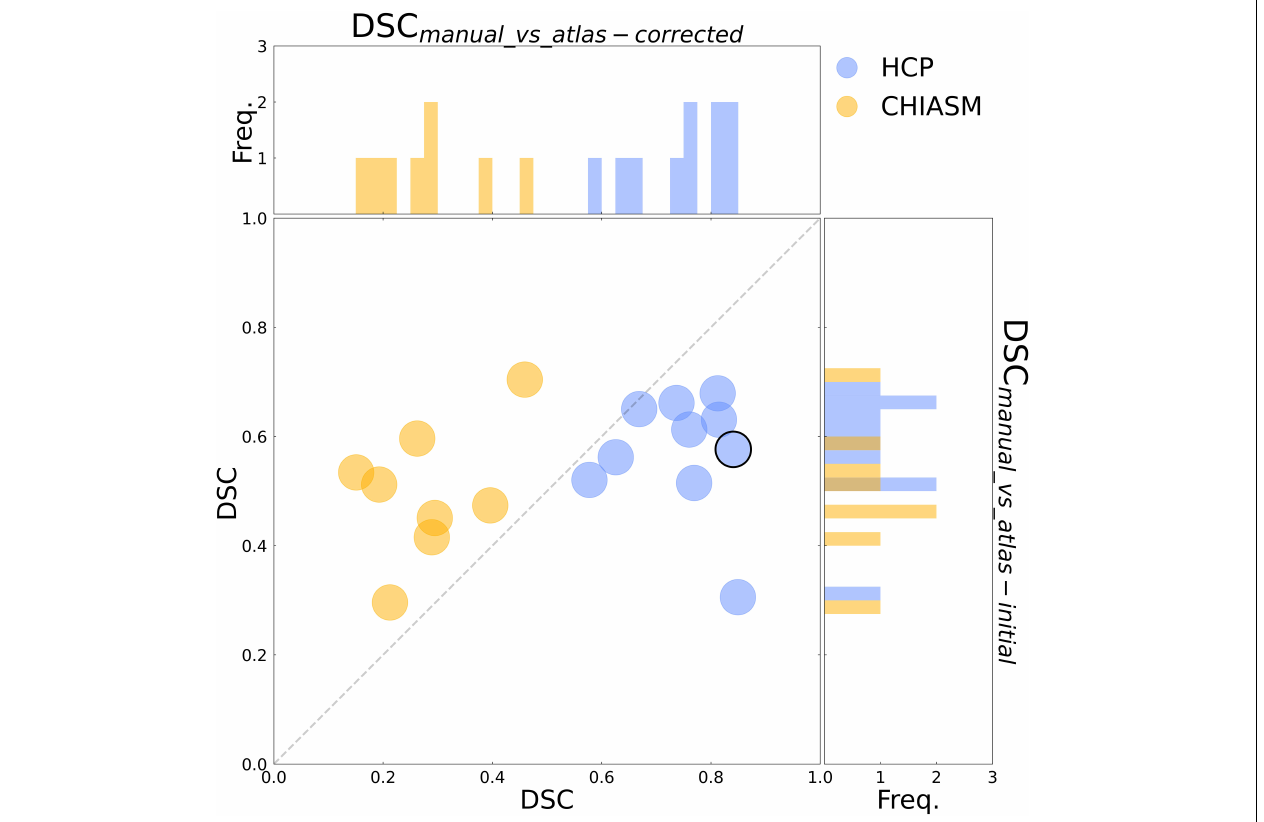
FIGURE 3 | Evaluation of the mask correction procedure. Scatter plot of DSC manual_vs_atlas − corrected (x-axis) and DSC manual_vs_atlas − initial (y-axis) values for a subset of 10 HCP test-controls and 8 controls from the CHIASM dataset. The values are additionally presented in the form of marginal histograms of the two distributions—DSC manual_vs_atlas − corrected (top horizontal) and DSC manual_vs_atlas − initial (right vertical). The black contour marks the data point of the representative participant detailed in Figure 1